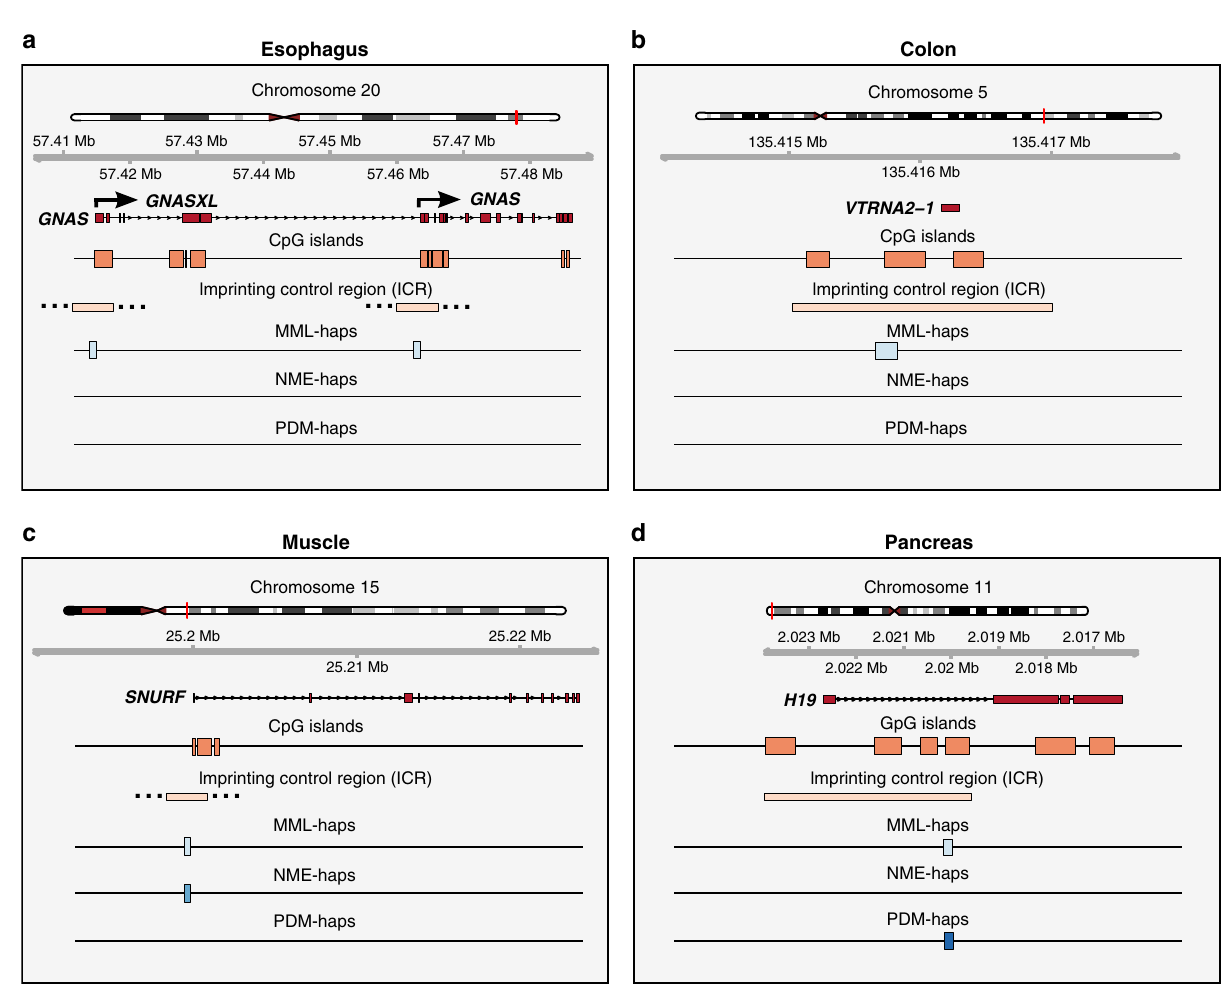
Fig. 6 Illustrative examples of signi fi cant haplotypes and imprinting. Haplotypes and their signi fi cance attributes overlapping the promoter regions of imprinted genes, identi fi ed by the CPEL method in different tissues of the same individual. a GNAS in esophagus, b VTRNA2-1 in colon, c SNURF in muscle, d H19 in pancreas. MML-haps: haplotypes exhibiting signi fi cant imbalances in mean methylation level; NME-haps: haplotypes exhibiting signi fi cant imbalances in normalized methylation entropy; PDM-haps: haplotypes exhibiting signi fi cant differences between the probability distributions of methylation within homologous alleles. The speci fi c location of the imprinting control regions (ICRs) for GNAS and SNURF is not